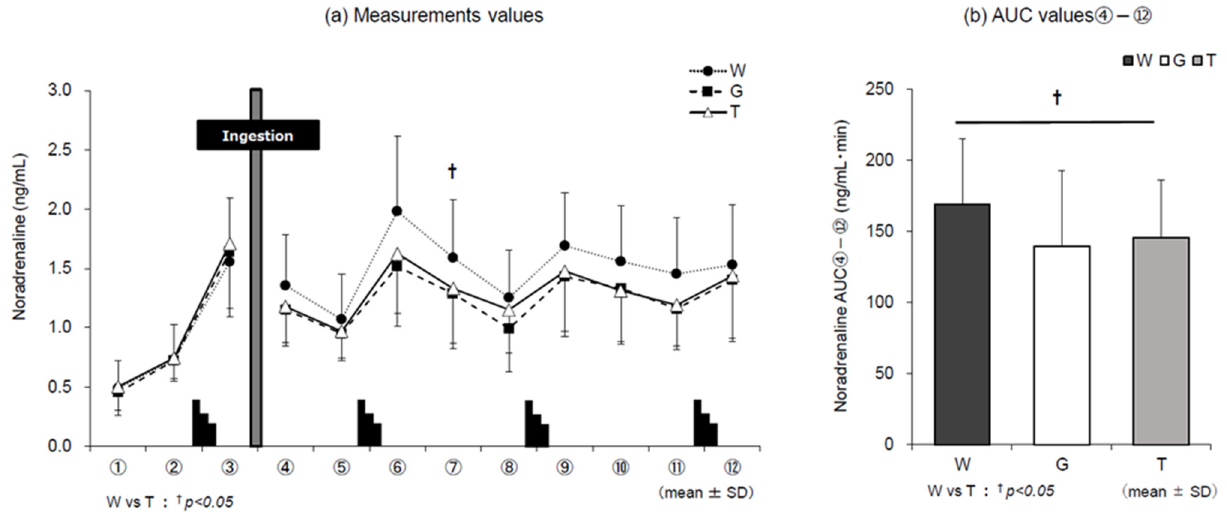
Figure 8. Changes in noradrenaline levels for each trial. W—water; G—glucose; T—trehalose. Changes in noradrenaline levels in each trial (water (W), glucose (G), trehalose (T)). Comparison between ( a ) measurements and ( b ) area under the curve (AUC) values ④ – ⑫ of each trial ( n = 12); W vs. T: † p<0.05.